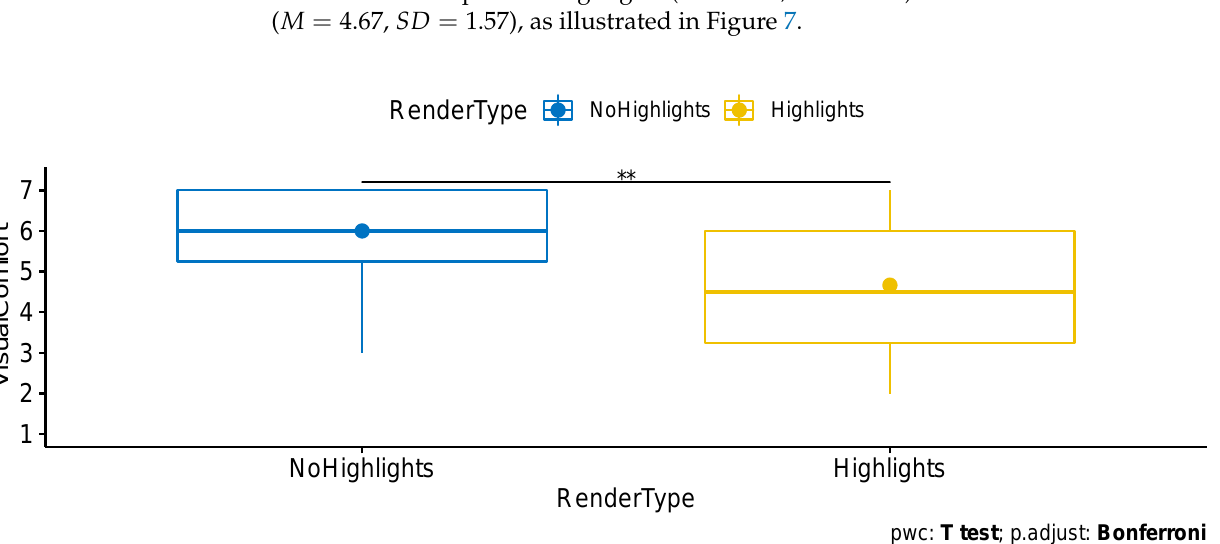
Figure 7. In the “Pyrite” scene, visual comfort (higher is more comfortable) was shown to significantly differ based on rendering